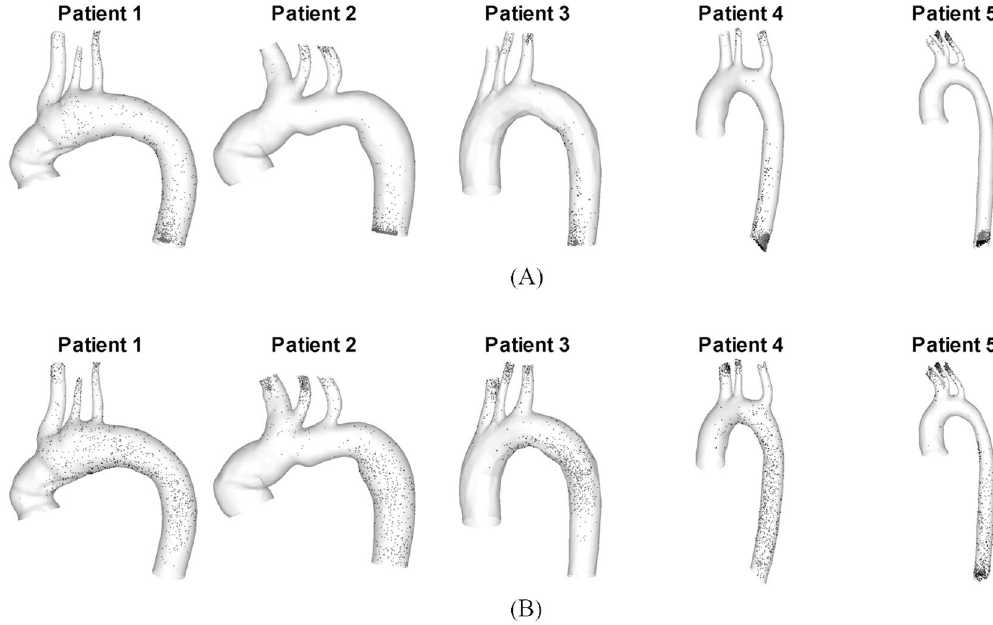
Figure 3. Distribution of clots at the peak stage of second cardiac cycle after released at the aortic inlet subject to the ( A ) normal and ( B ) AF flow condition within the aorta model reconstructed from patient 1 to